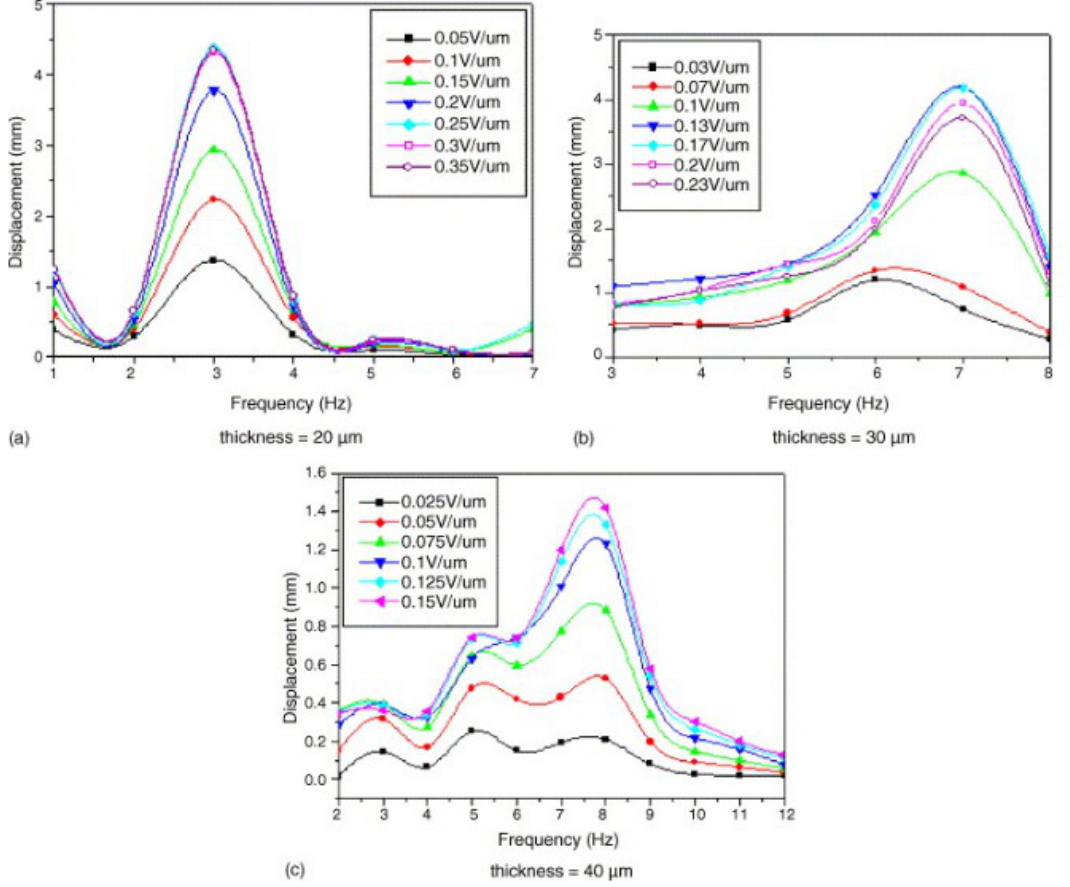
Figure 13. ( a – c ) Tip displacements of EAPap actuators with thickness variation